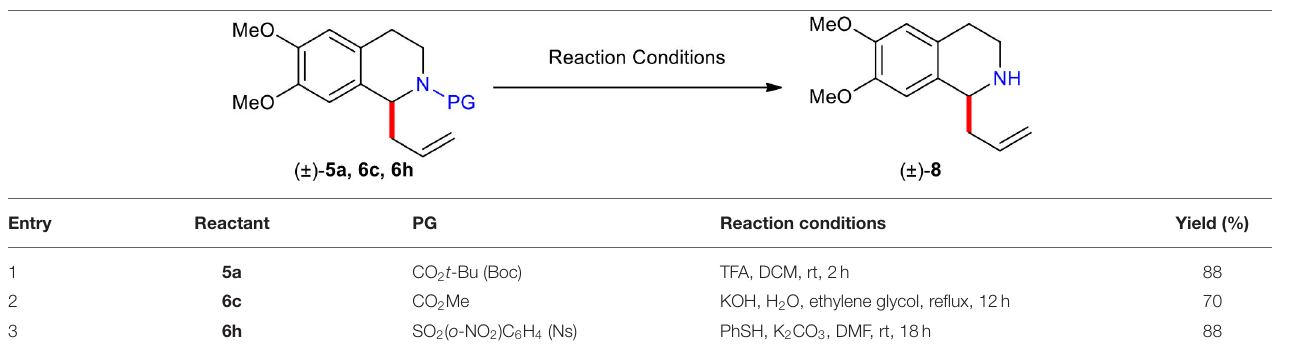
TABLE 2 | Liberation of C(1)-allylated 1,2,3,4-THIQ ( ± )– 8 from ( ± )– 5a , 6c , and 6h